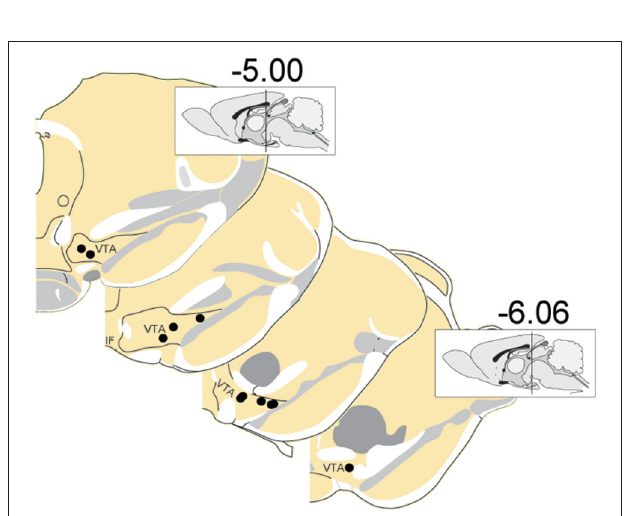
FIGURE 2 | Locations of recording electrodes within VTA. Each dot represents the location of a recording array. Insets show midsagittal diagram of rodent brain with vertical lines representing the approximate location of the most anterior and posterior coronal sections shown.